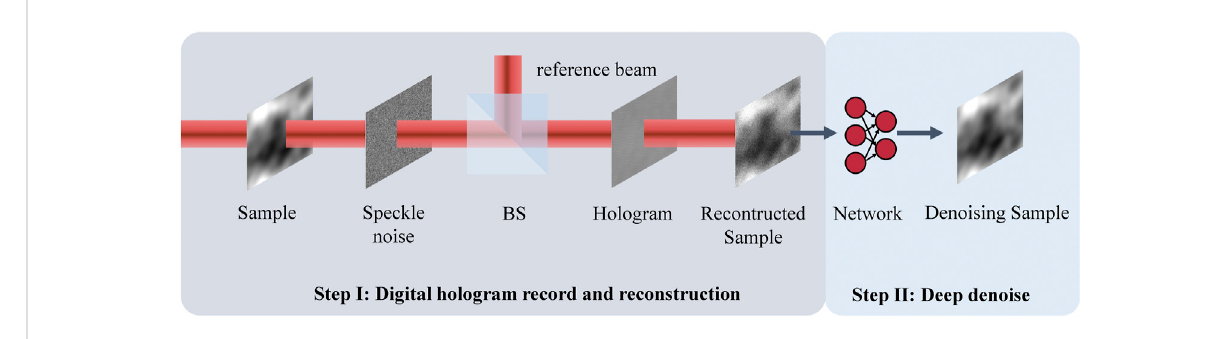
FIGURE 1 The schematic diagram for the label-free coherent noise suppression in digital holographic